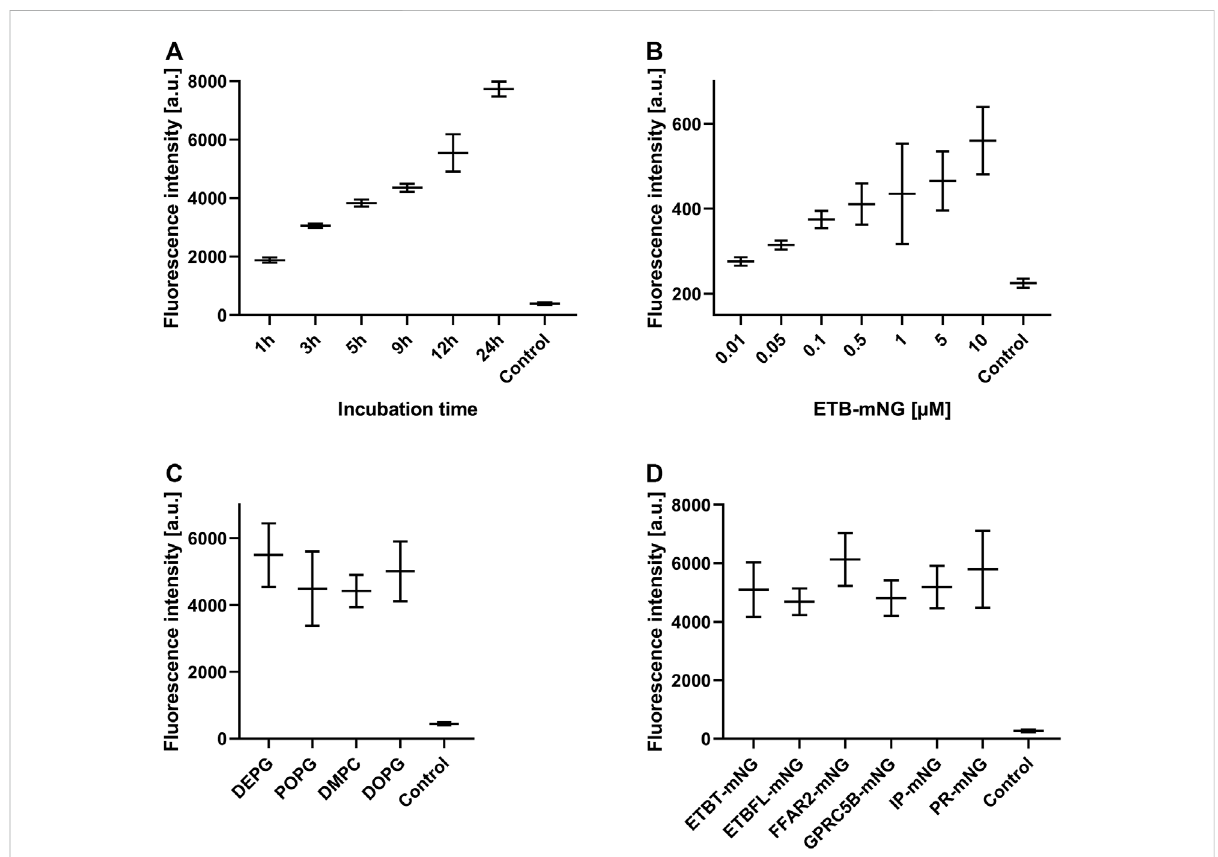
FIGURE 3 Evaluation of MP transfer ef fi ciency into HEK293T cells. HEK293T cells were incubated with Strep-puri fi ed MP/ND particles at standard conditions (0.5 μ M MP/ND particles, 4 h transfer) with the indicated modi fi cations. After transfer, cells were fi xed, and membrane fl uorescence was quanti fi ed. (A) EffectofincubationtimesonETB-mNGtransfer. (B) EffectofETB-mNG/NDparticleconcentration. (C) TransferofPR-mNGfromNDs containing either DEPG, POPG, DMPC, or DOPG lipids. (D) Transfer of GPCR-mNG and PR-mNG fusions from NDs containing customized membrane compositions (ETB-mNG/ND (DEPG), ETB-tc-mNG/ND (DEPG), FFAR2-mNG/NDs (POPG), GPRC5B-mNG/NDs (POPG), IP-mNG/NDs (DEPG) and PR-mNG/NDs (DEPG)). Mean ± SEM is shown. N = 20 cells. Controls are fl uorescence of HEK293T cells after incubation with NDs without